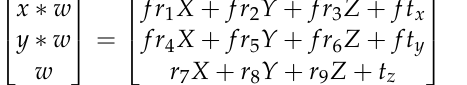
(cid:113) ( x − x (cid:48) ) 2 + ( y − y (cid:48) ) 2 + ( z − z (cid:48) ) 2 .